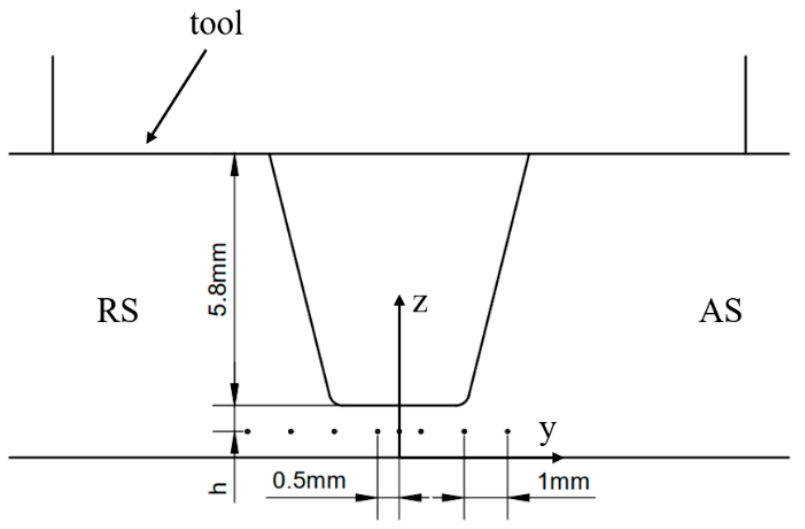
Figure 7. Distribution of test points at the root of the weld.